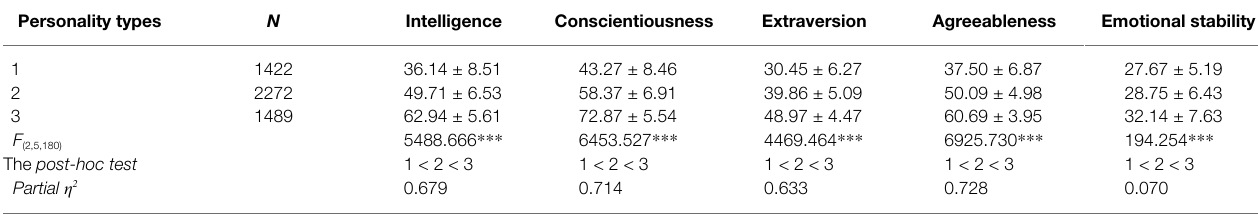
TABLE 3 | Descriptive statistics, analysis of variance, and post-hoc tests on personality types in five dimensions. Personality